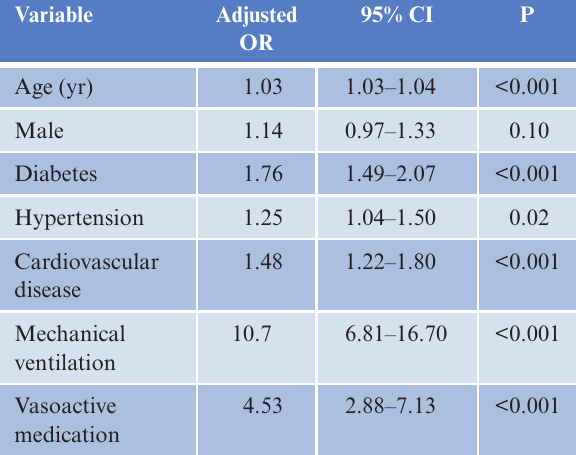
Table 1. Univariate and multivariate logistic regression anal- yses of risk factors associated with the development of AKI in COVID-19